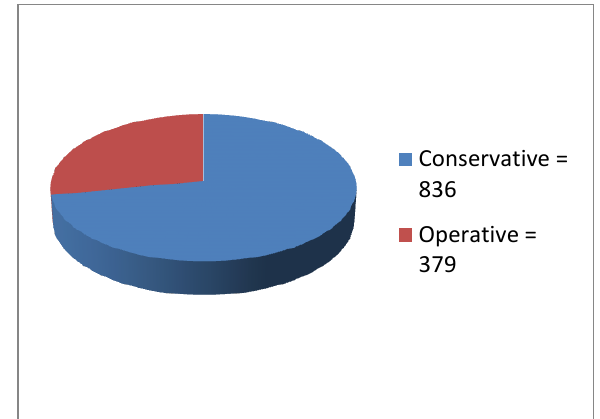
Fig 1: Pie shows the number of patients underwent conservative versus operative